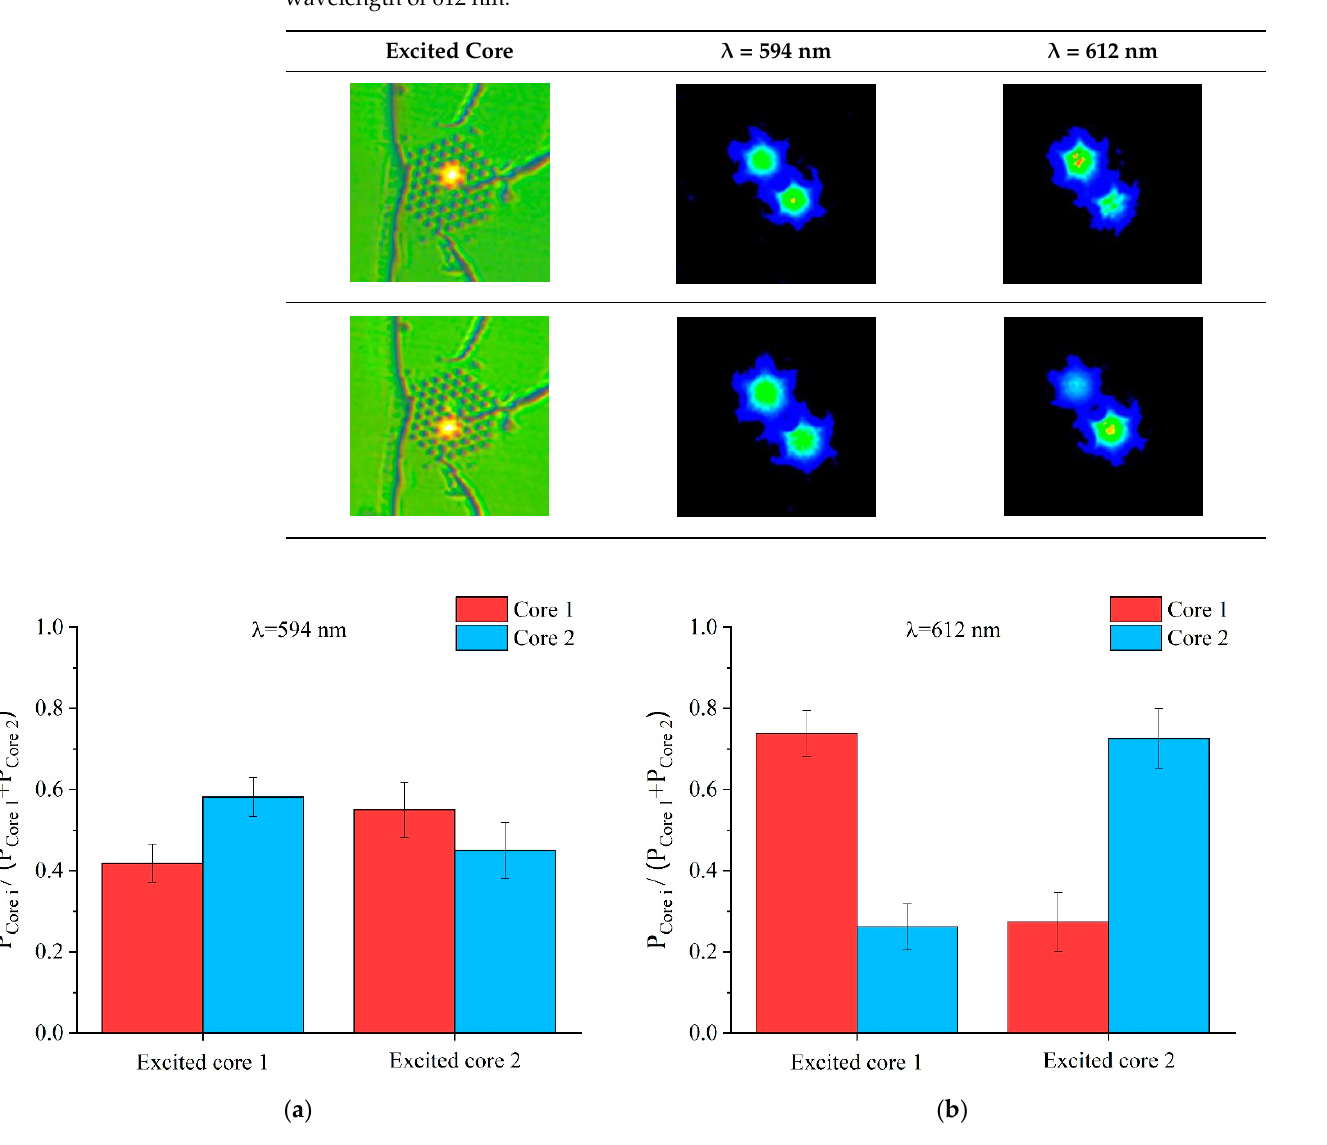
Figure 9. Power ratio (given as average value and standard error of the mean) of each core at the output end-face of a 38 cm-long fiber, when each core is individually excited at wavelengths of ( a ) 594 nm and ( b ) 612 nm ( i stands for the core index: {1, 2}).